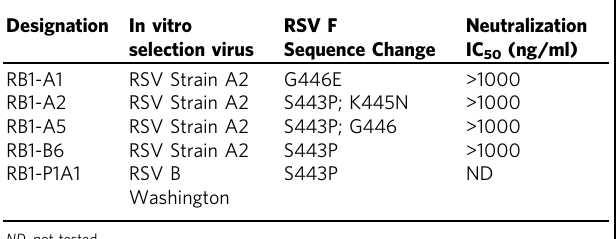
Table 4 Monoclonal antibody-resistant mutants (MARMS) for RSV A and